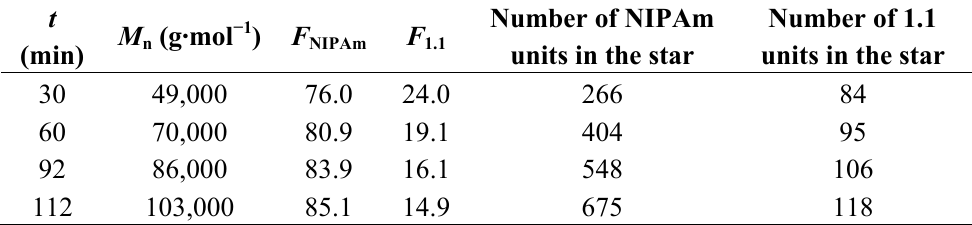
Table 4. Molecular shares of both monomers and number of monomer units per star molecule in the samples of the copolymerization with 5000 mmol·L − 1 NIPAm